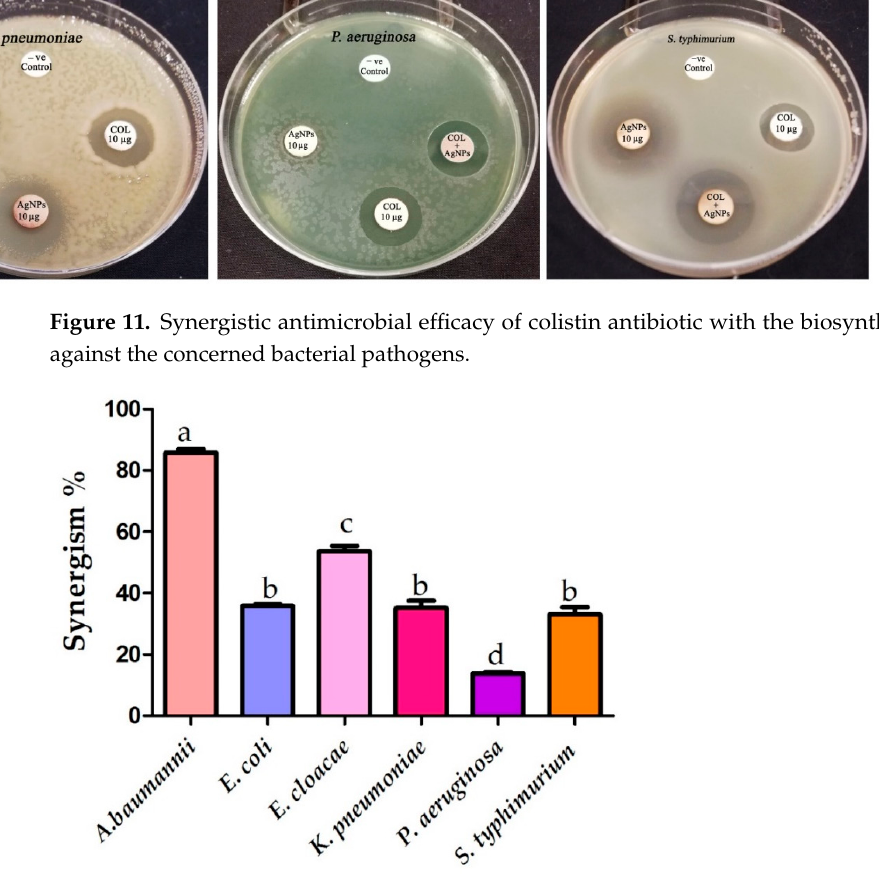
Figure 12. Synergistic percentages of the green synthesized silver nanomaterials with colistin antibiotic (different letters indicate values that were significantly different ( p ≤ 0.05)). Table 3. Synergistic antibacterial activity of the biogenic AgNPs with colistin antibiotic against the tested